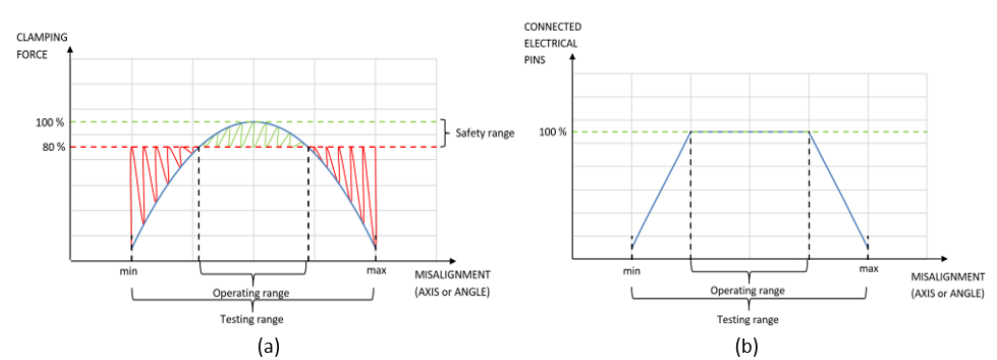
Figure 13. ( a ) Results to be achieved for locking mechanisms and ( b ) results to be achieved for electrical